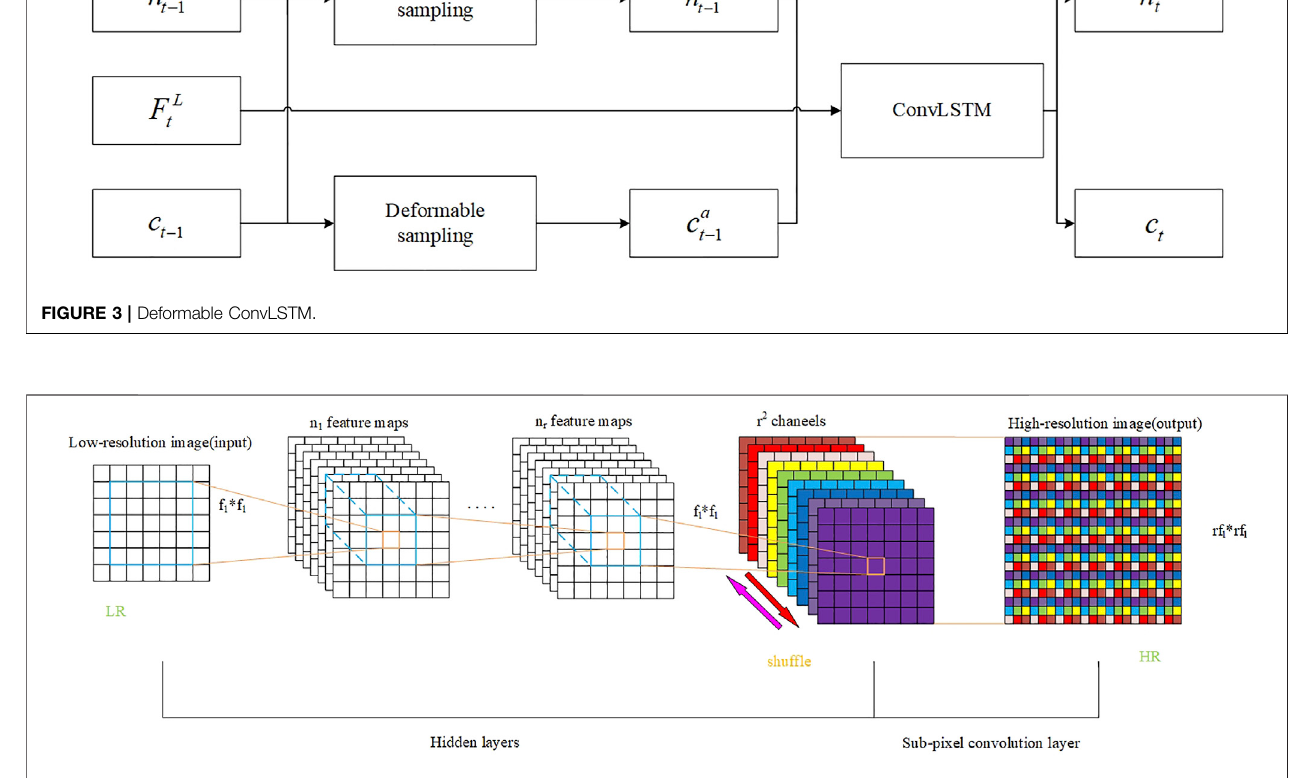
FIGURE 4 | Sub-pixel upscaling